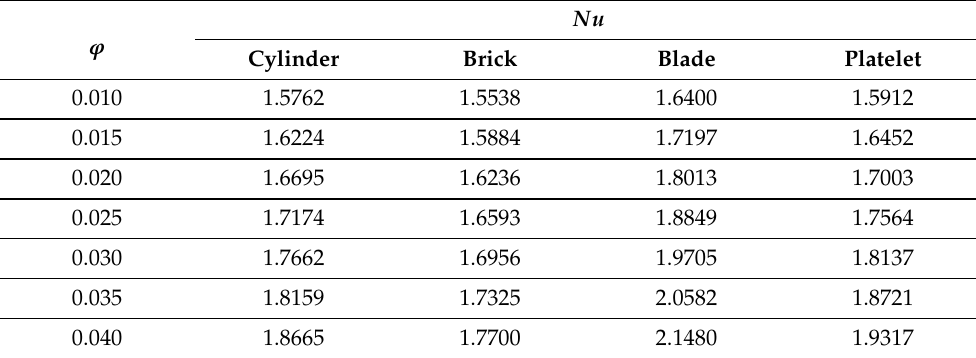
Table 5. Investigation of Nu for multiple shapes of